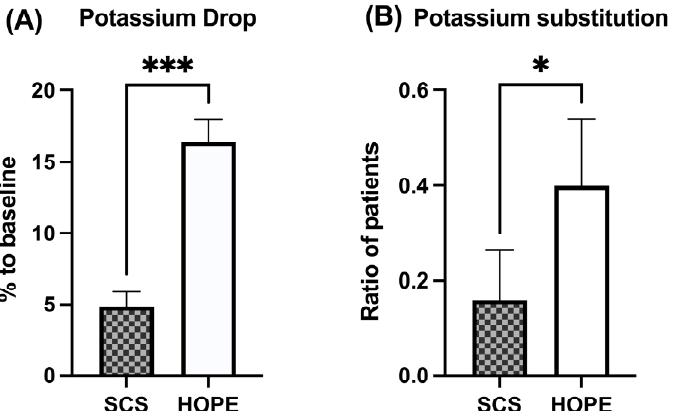
Figure 2. Graphical analysis of relative decrease in serum potassium levels and need for potassium substitution, immediately after liver graft reperfusion (Mean ± 95% ‐ CI). HOPE preconditioning re ‐ sults in significantly higher drops in serum potassium levels ( A ) p < 0.001) and a more frequent need for potassium substitution ( B ) p = 0.014), as compared to SCS. (* = p < 0.05, *** = p < 0.001)